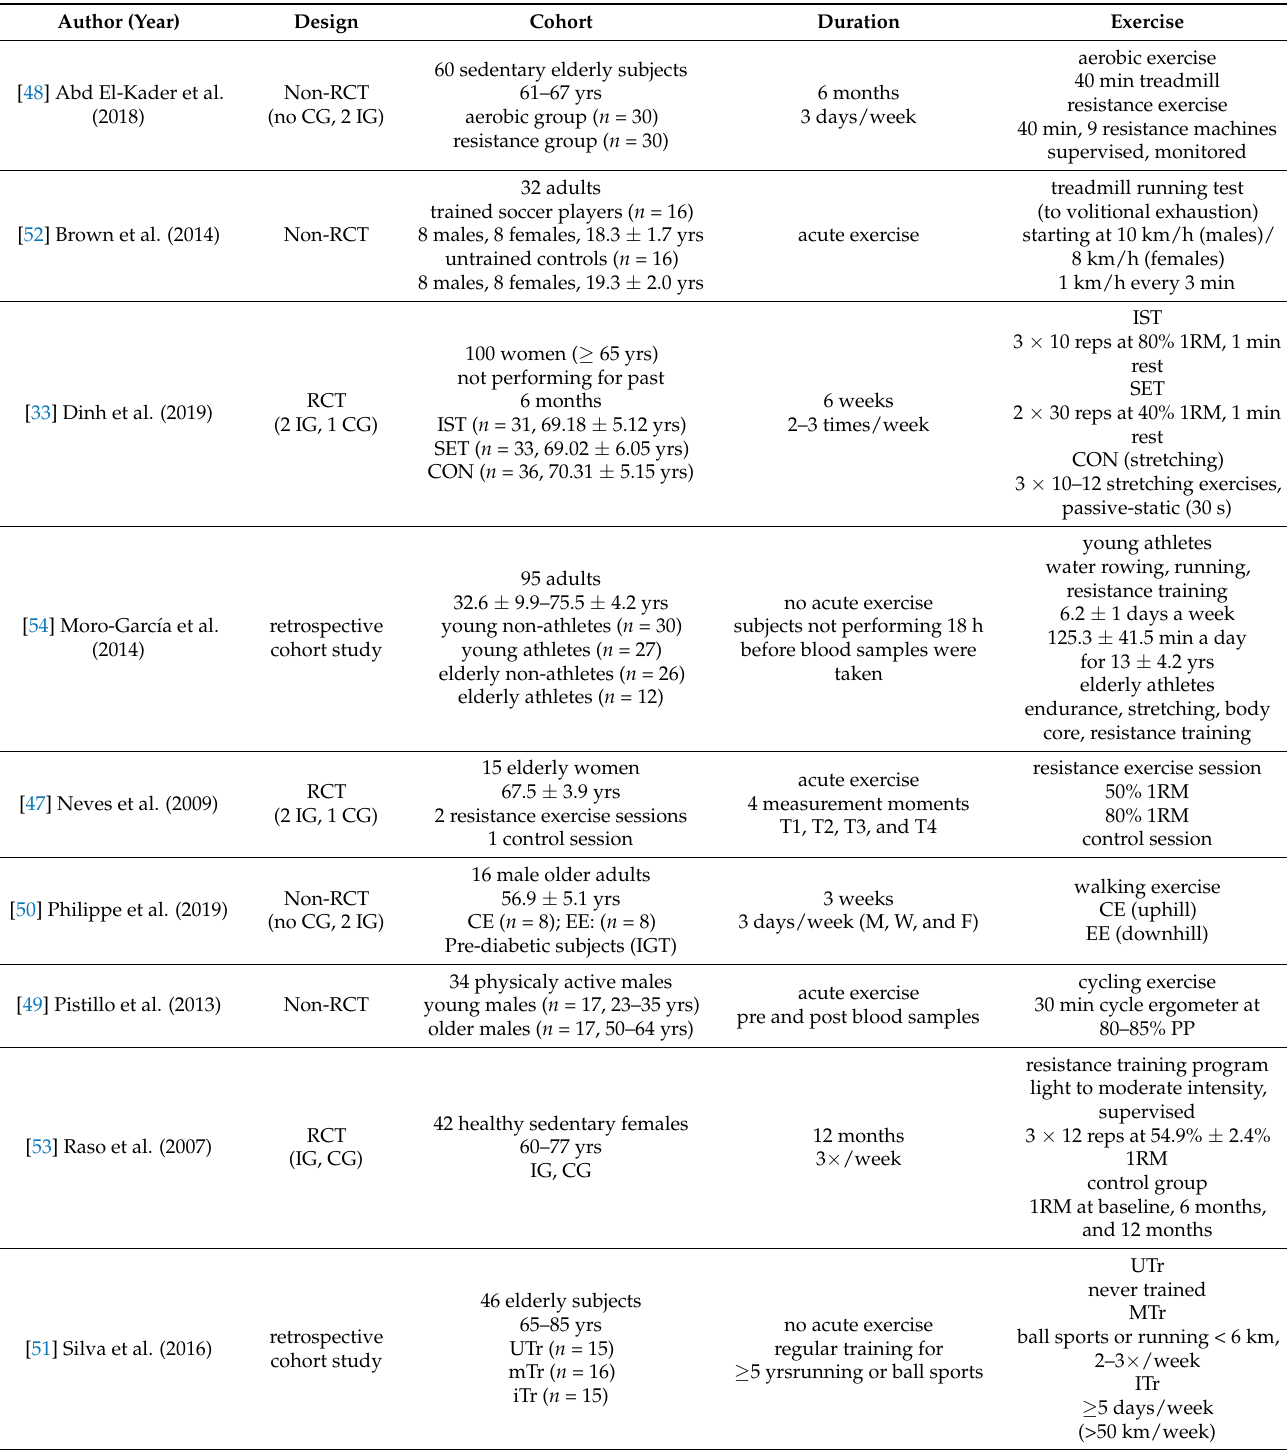
Table 6. Characteristics of included exercise training studies ( n =